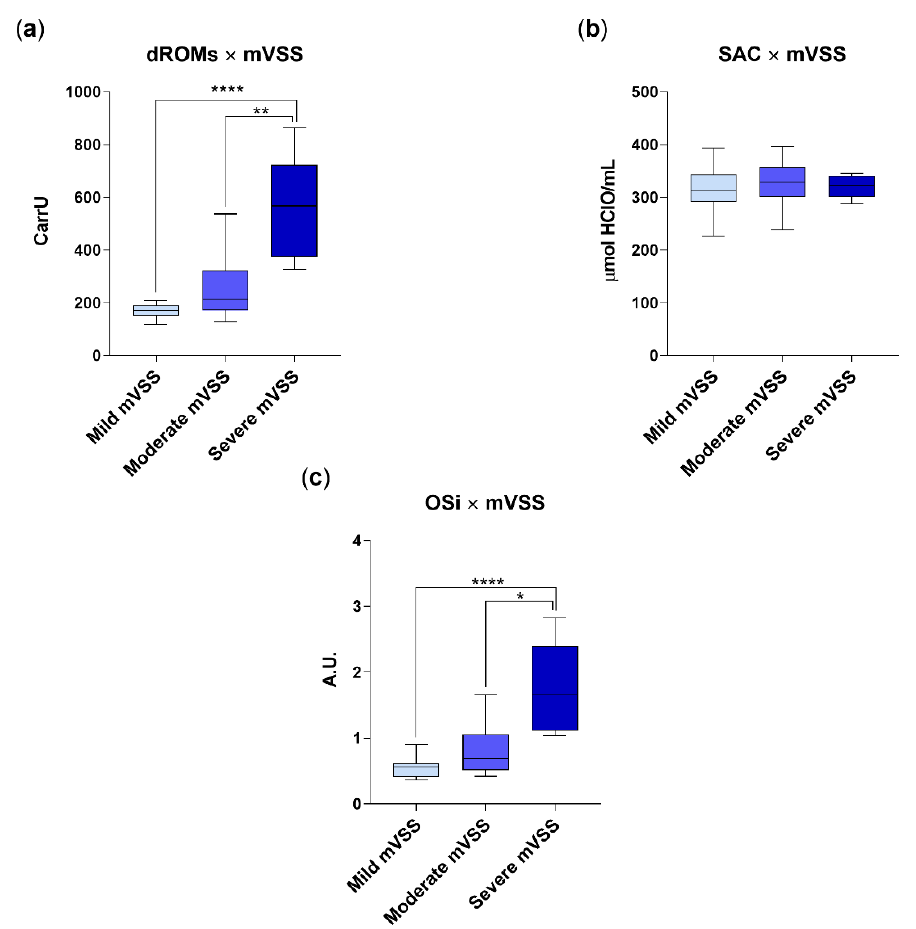
Figure 2. dROM ( a ), SAC ( b ) and OSi values ( c ) in group AD (diarrhetic dogs, n = 45), categorized on the basis of mVSS. Mild mVVS subgroup includes dogs with a mVVS score < 5; moderate mVVS subgroup includes dogs with a mVVS score from 6 to 10, and severe mVVS subgroup includes dogs with a mVSS score > 11. Data are represented as boxplot showing median and interquartile range and analyzed by Kruskal–Wallis test followed by Dunn’s multiple comparisons. Statistical differences between groups are reported (* p < 0.05; ** p < 0.001; **** p < 0.0001,).